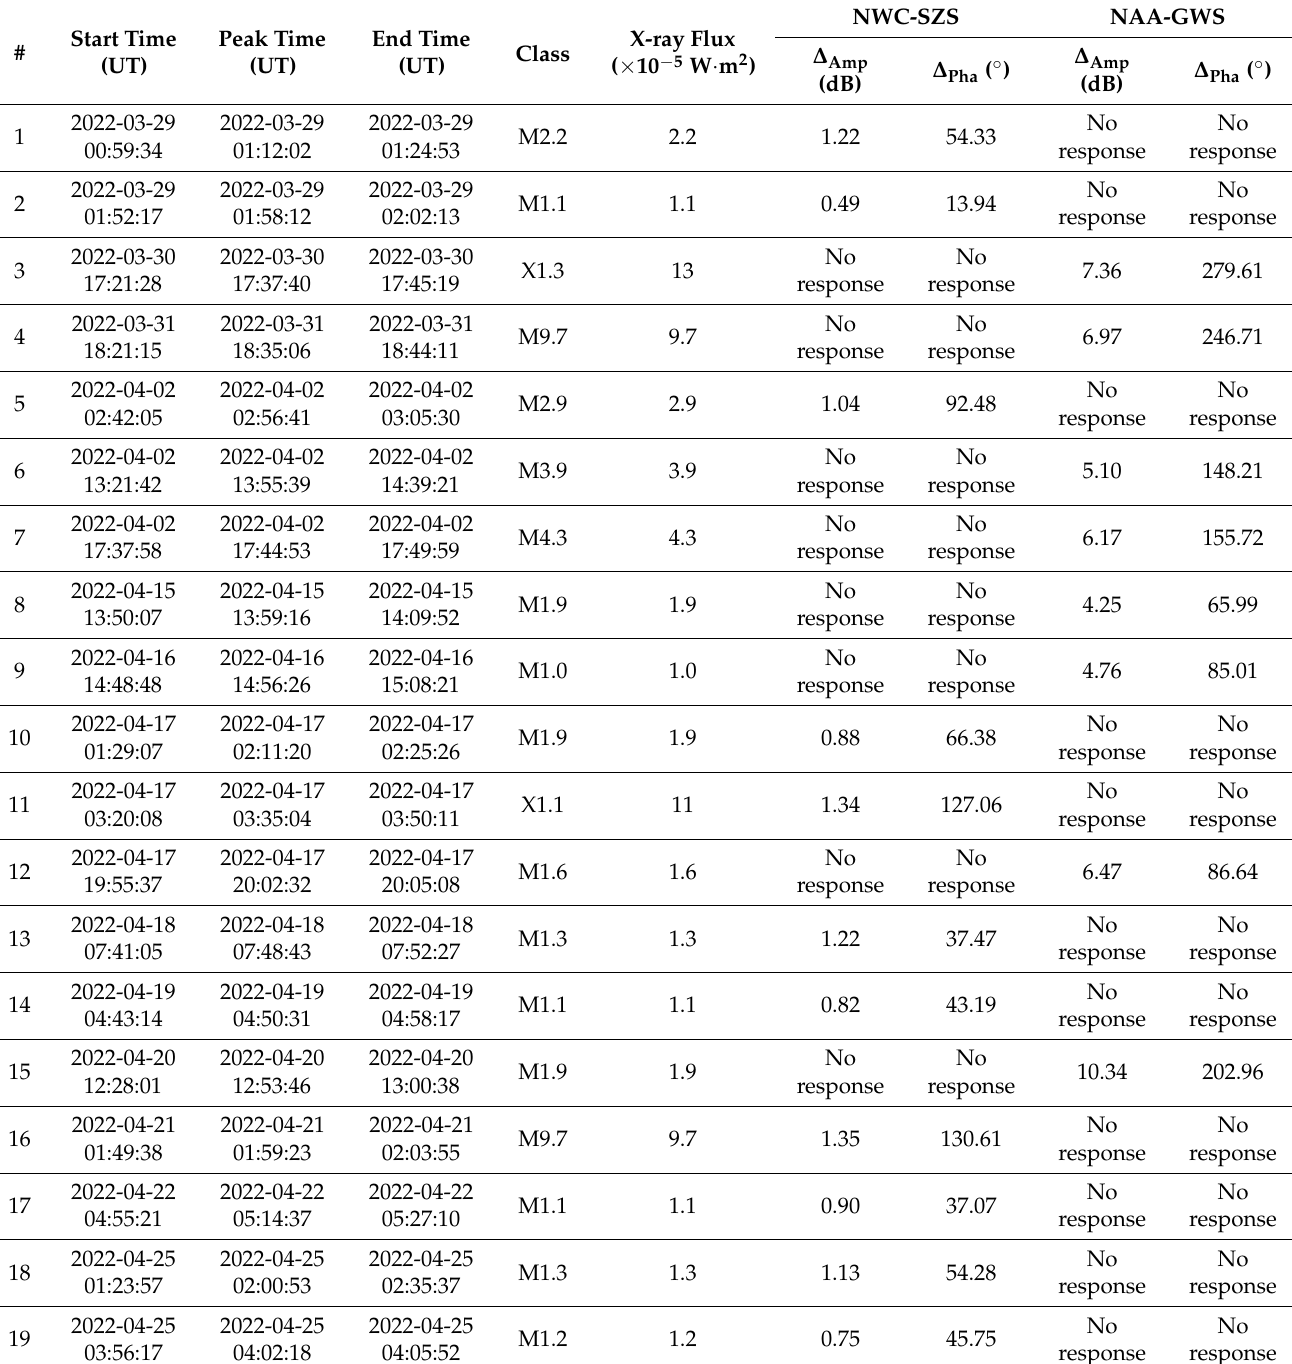
Table 1. List of the solar flare events and the corresponding responses of NAA and NWC transmitter signals during the period from 25 March 2022 to 25 May